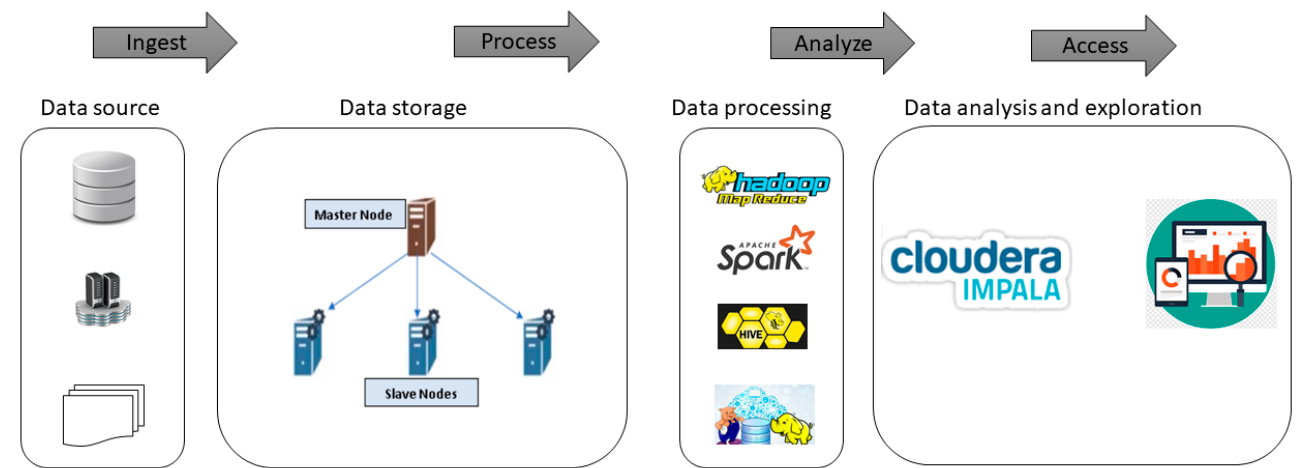
Figure 1. Data analysis architecture in a big data environment.